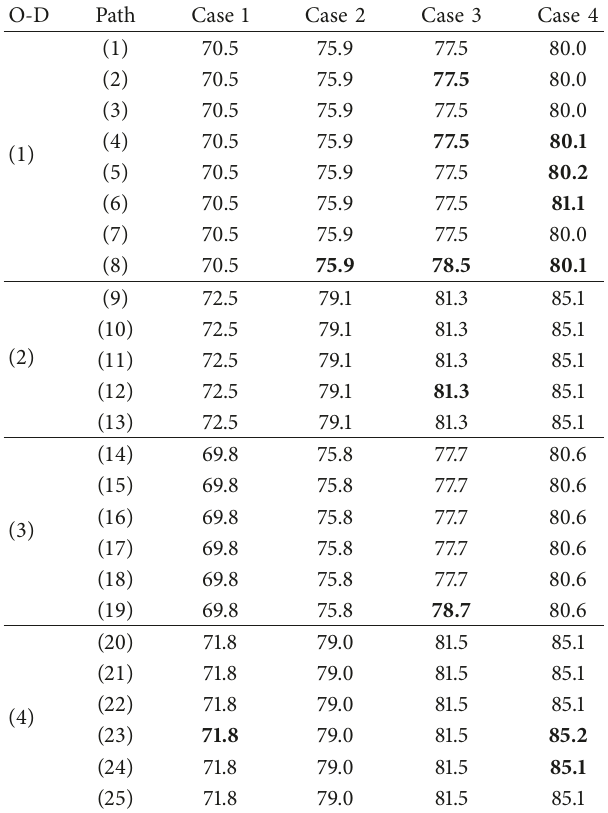
Table 3: Assumptions of each case.